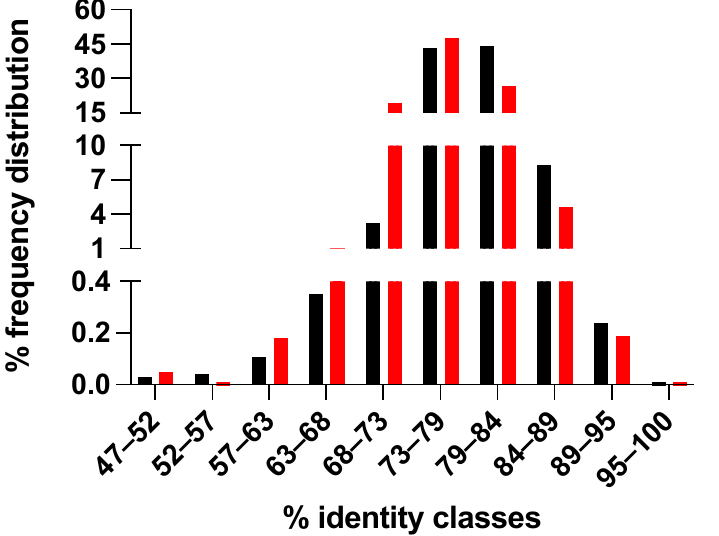
Figure 2. Evolution of the env and asp ORFs in the region of overlap. Using the dataset of 3725 env sequences that overlap an ‘intact’ asp ORF, we first translated each env and asp nucleotide sequence into the corresponding ENV and ASP amino acid sequence. We then carried out a total of (3725 × 3724)/2 pairwise comparisons of ENV and ASP amino acid sequences. Each comparison assessed the number of amino acid identities and differences that were found in ENV (black bars) with those that were found in ASP (red bars) using the contingency-table χ 2 test [42]. The frequency distribution of the amino acid identity in ENV (black bars) was very similar to that in ASP (red bars), with only 792 cases (0.011%) showing a χ 2 > 3.84 (1 degree of freedom, p < 0.05). The mean amino acid identity of ENV (79.0%; sd = 3.6%) was found to be close to that of ASP (76.7%; sd = 4.3%). These findings indicated the env/asp evolved